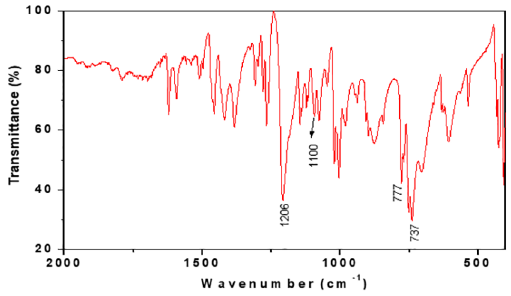
Figure 2. FTIR spectrum of the Benzotriazole